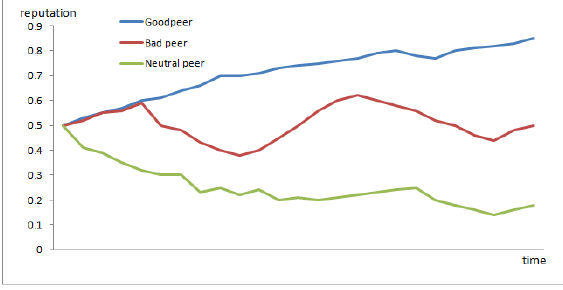
Fig. 3. Trends of reputation when there exist 50% malicious peers.